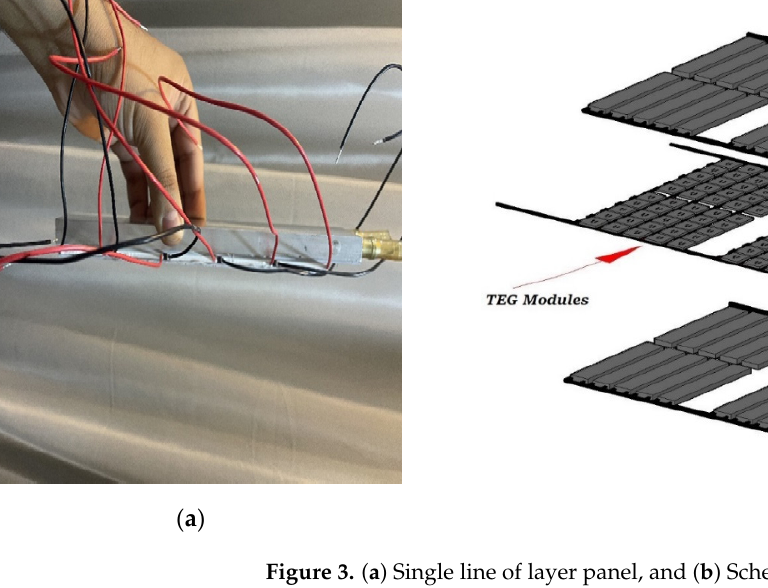
Figure 5. Pipes and integration of the system . Then, acrylic plates are installed on the two surfaces of the panel in a sandwich con- figuration so that all the connecting parts are installed correctly and evenly.